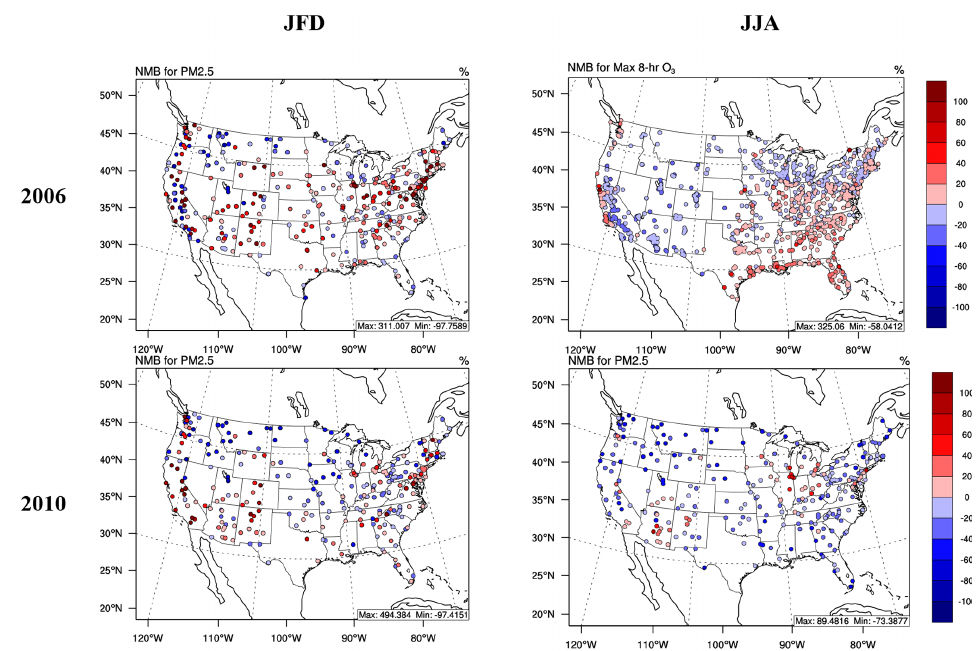
Figure 4. Diurnal variation of T2 (top row) and hourly O 3 concentrations (bottom row) against CASTNET for JJA 2006 and